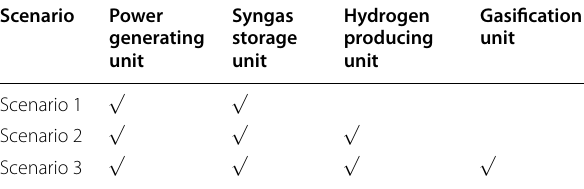
Table 2 Operation strategies for the different power